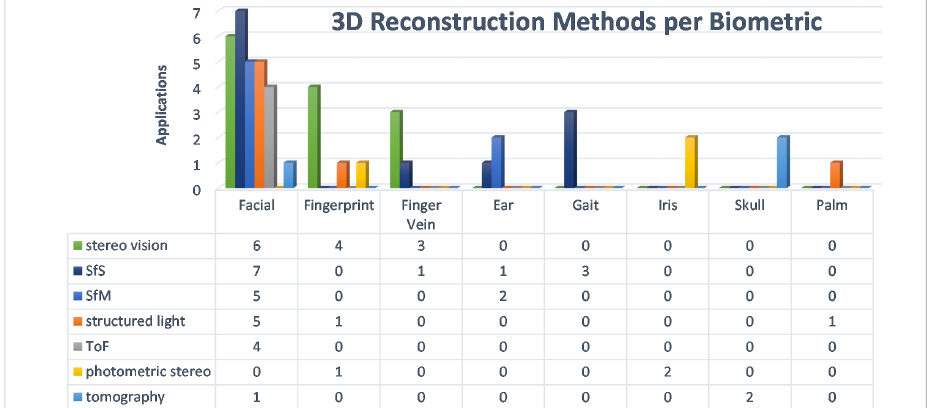
Figure 12. 3D Reconstruction Methods per Biometric.